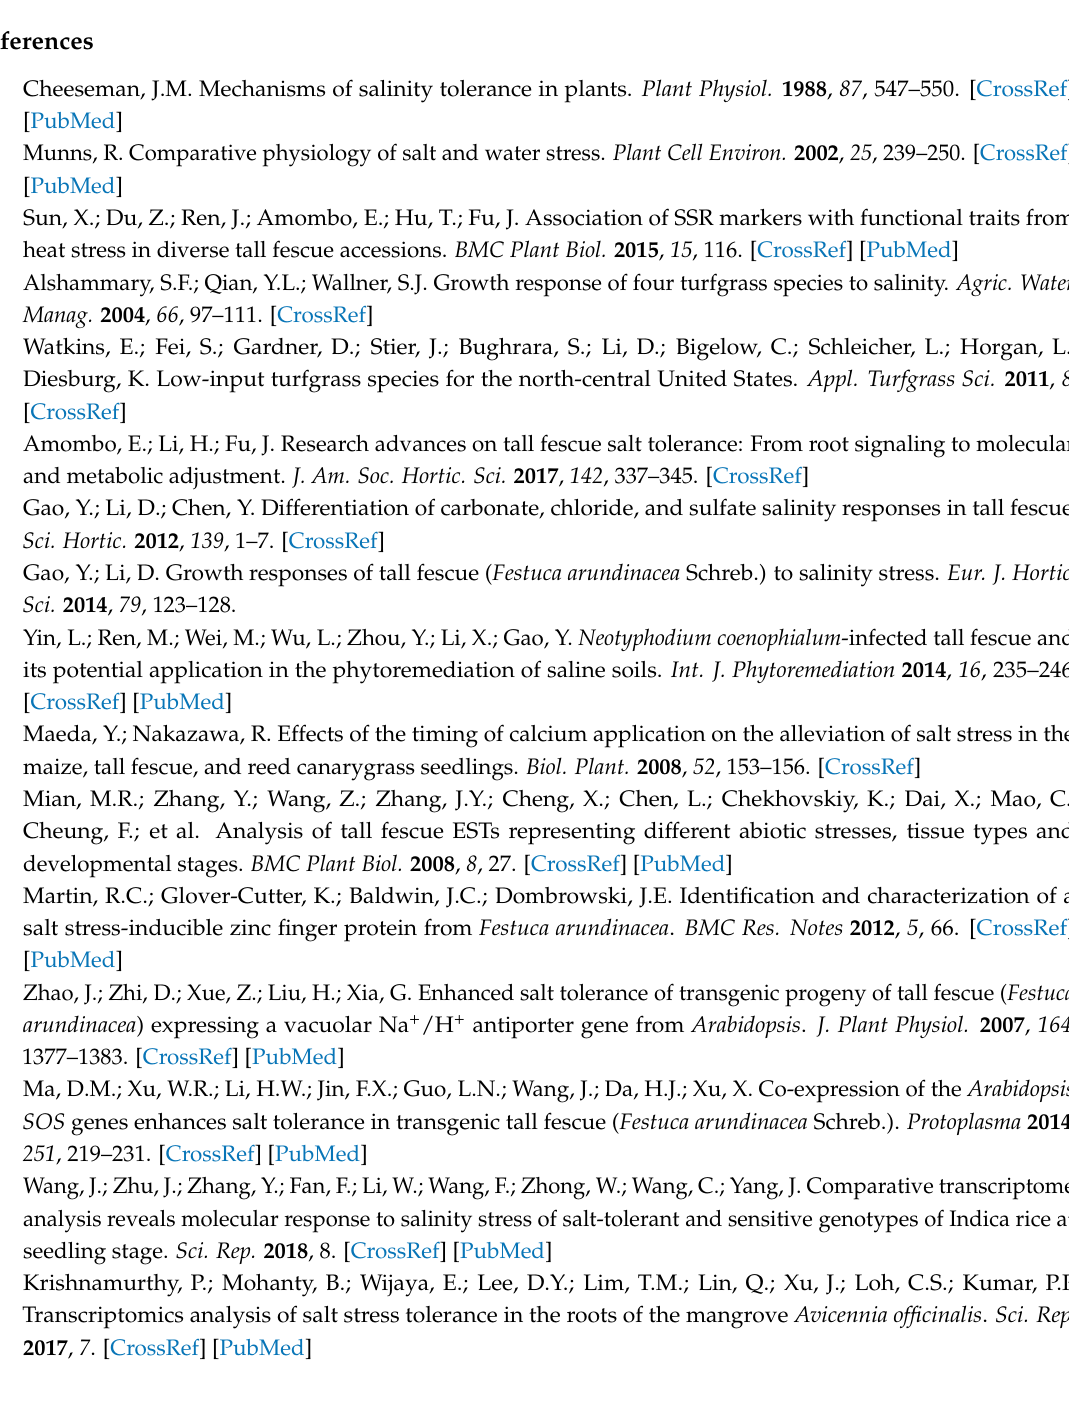
Functional database annotations, Table S3: Transcription factors, Table S4: Coding DNA sequence, Table S5: SSR primer sequence, Table S6: Differentially expressed genes, Table S7: DEG clusters, Table S8: Comparative differential gene